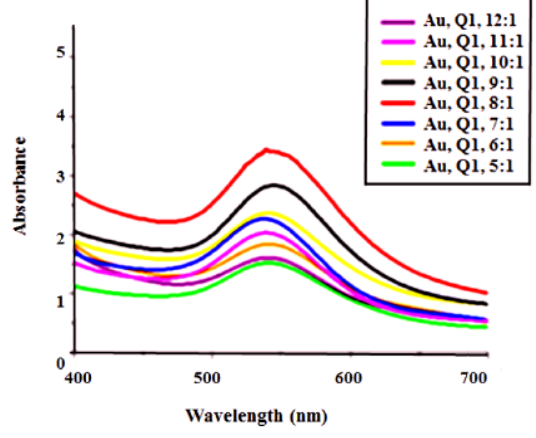
Figure 1. Optimization of GNPs.